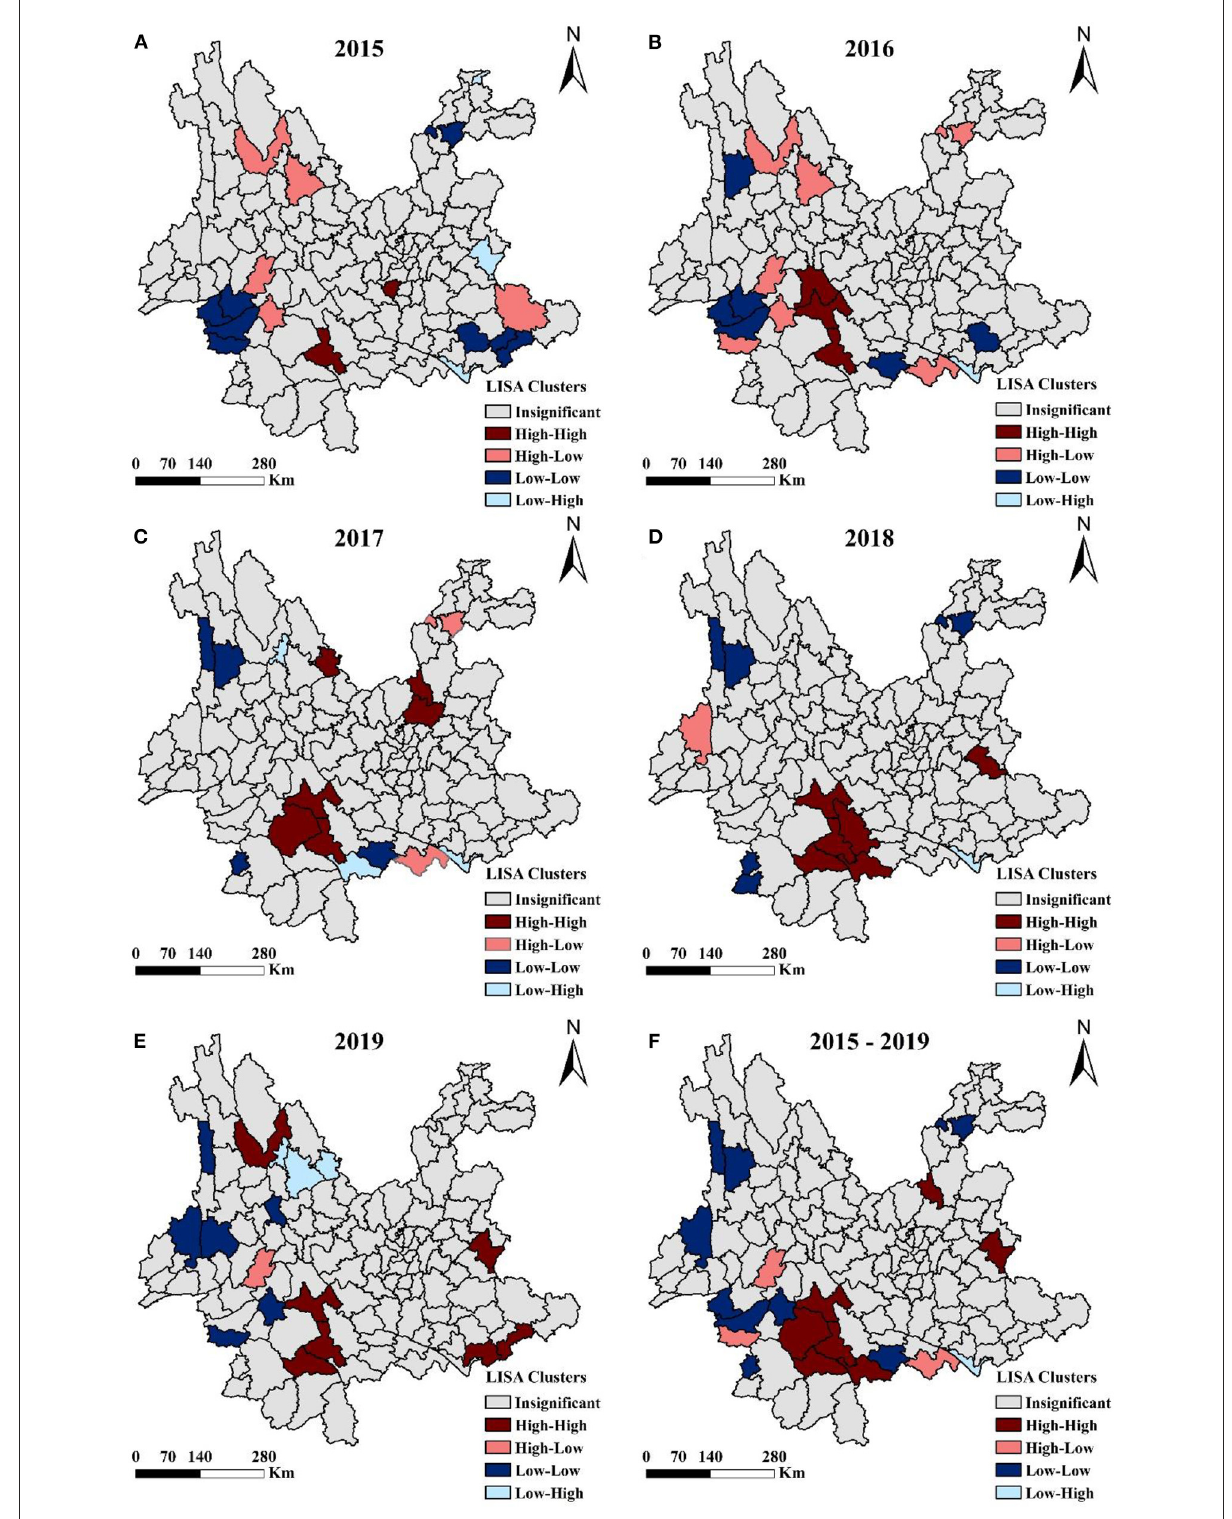
FIGURE5 LISA maps of liver cancer mortality in Yunnan at county level, 2015–2019. (A–E) year 2015–2019, (F) year 2015–2019 on average.